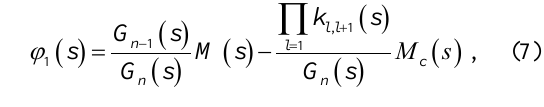
Fig. 6. Block diagram of the discrete model of the mechanical parts of the drive.